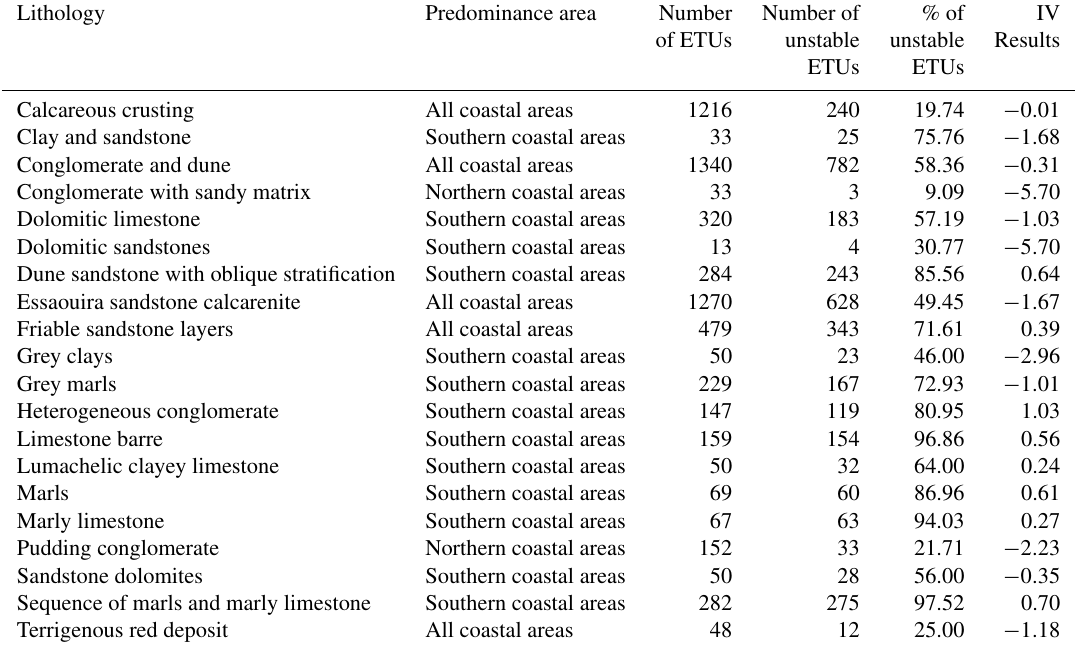
Table 4. Predominance lithology by area and ETU. Lithology